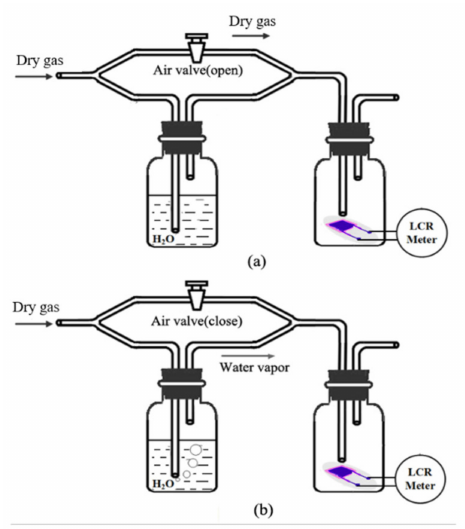
Figure 9. The dynamic test setup: ( a ) get dry gas (about 3% RH) when the valve is open; ( b ) get wet gas (about 96% RH) when the valve is